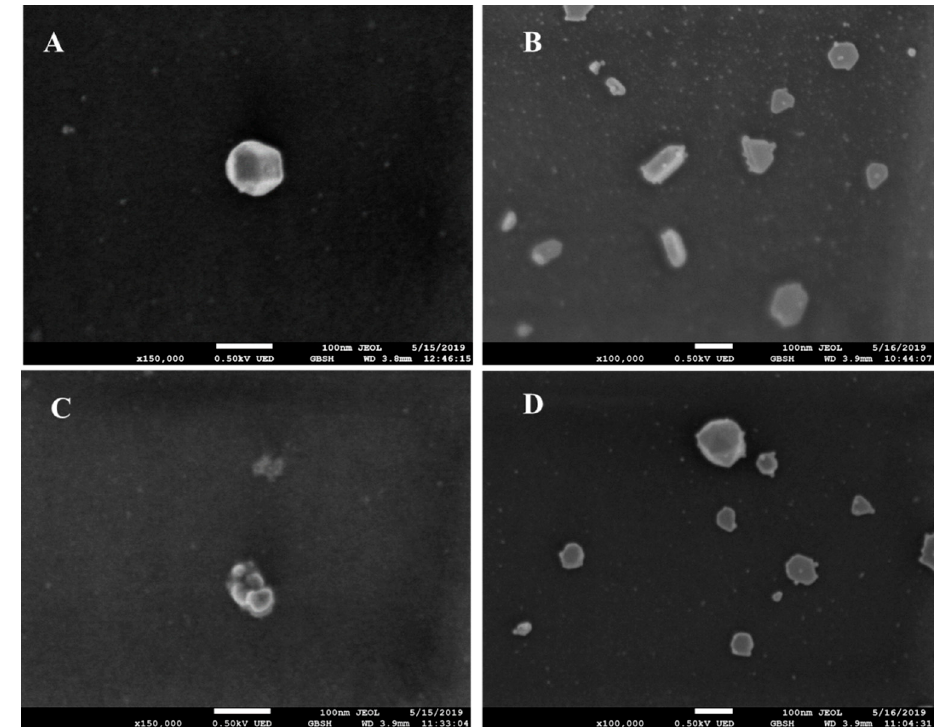
Figure 4. SEM images of AgNPs with magnification 150,000 × ( A ), AgNPs / 100,000 × ( B ), QNZ 6-AgNPs / 150,000 × ( C ), QNZ 6-AgNPs / 100,000 × ( D ). Images were recorded on field-emission scanning electron microscope (FE-SEM) (JEOL, 7800F) instrument. Scale bar represents 100 nm.